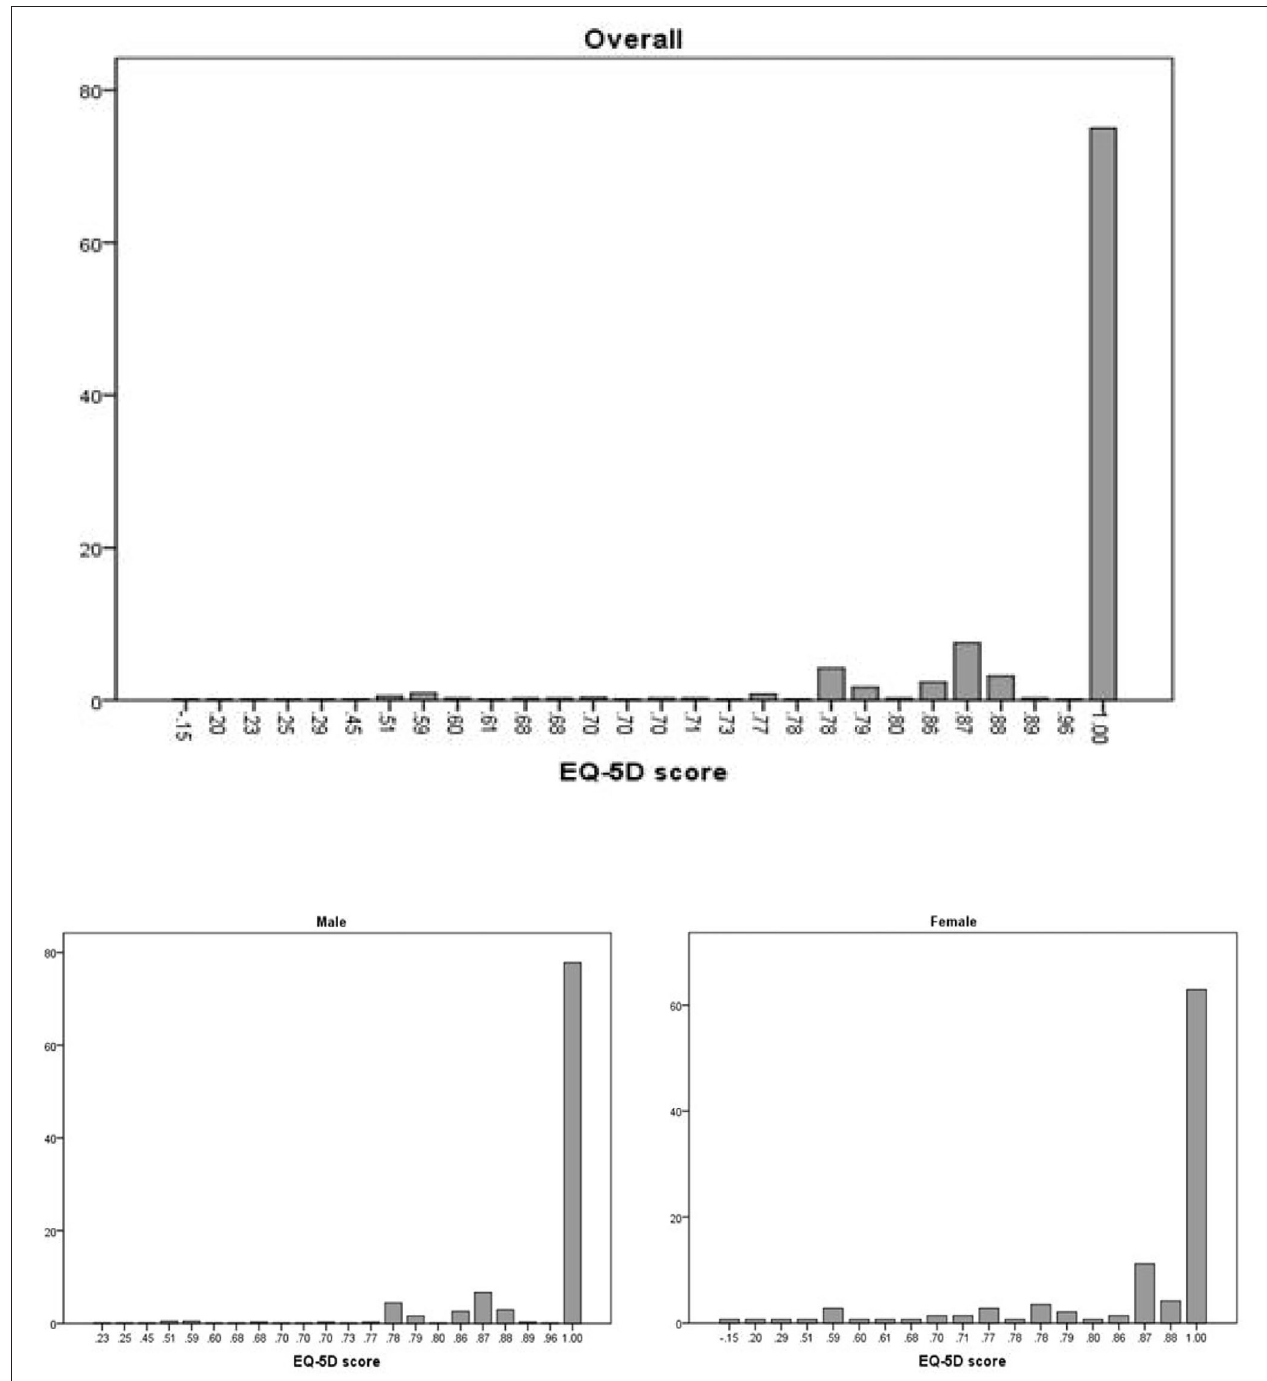
FIGURE 1 | The distribution of the EQ-5D index score.